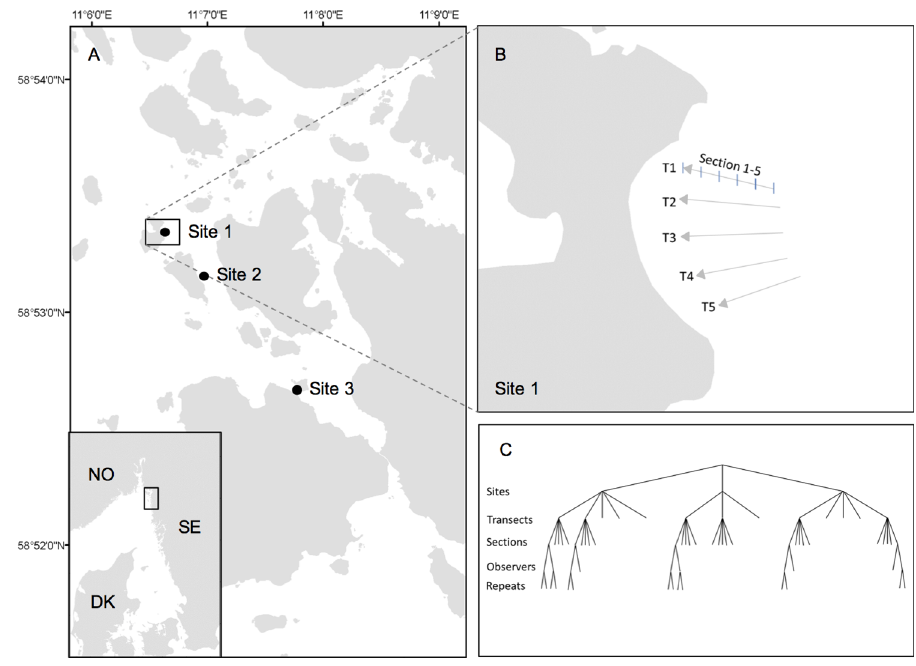
Fig 1. Study location and experiment design. (A) Study location,(B) study site 1 (Lo¨kholmen) with schematic scale diagram of sample transects and sections and (C) experiment design.